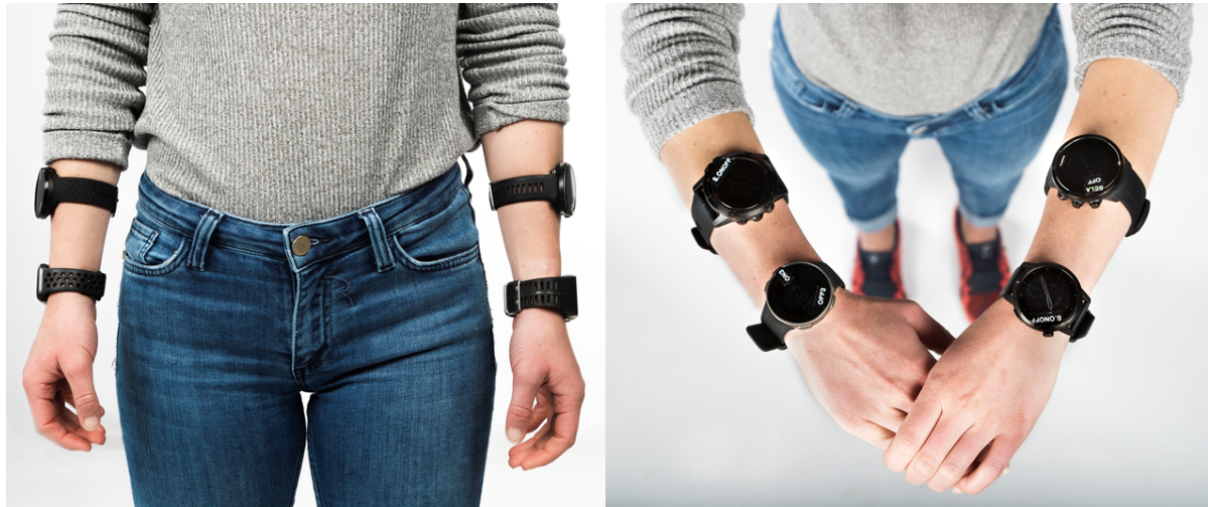
Figure 2. Randomly assigned wearing position on the forearm of the sport watches during one measurement (left). Calibration posture with arms outstretched to achieve the best global navigation satellite signal quality